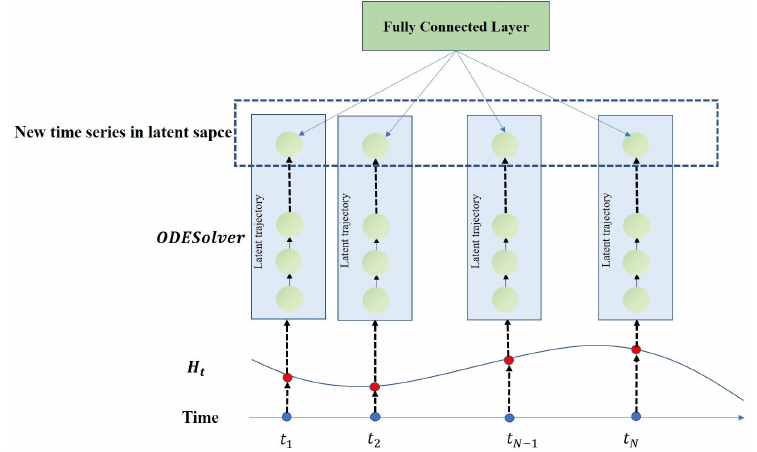
Figure 4. The structure of the NODE